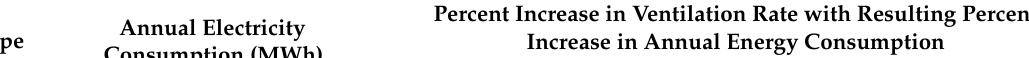
Table 1. Percent increases in annual energy use with varying increases in ventilation rates, as estimated by the virtual energy audits (except for the healthcare